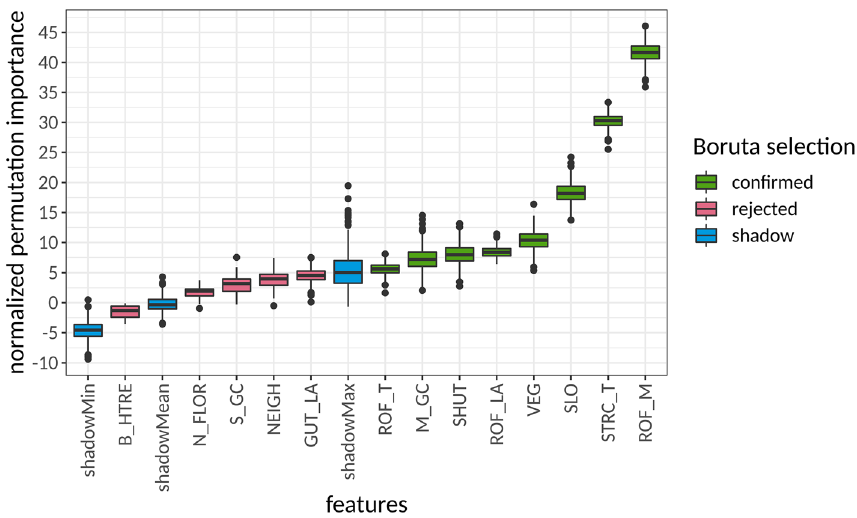
Figure 3. Results of the Boruta selection for indicators related to the vulnerability of buildings to wildfire.